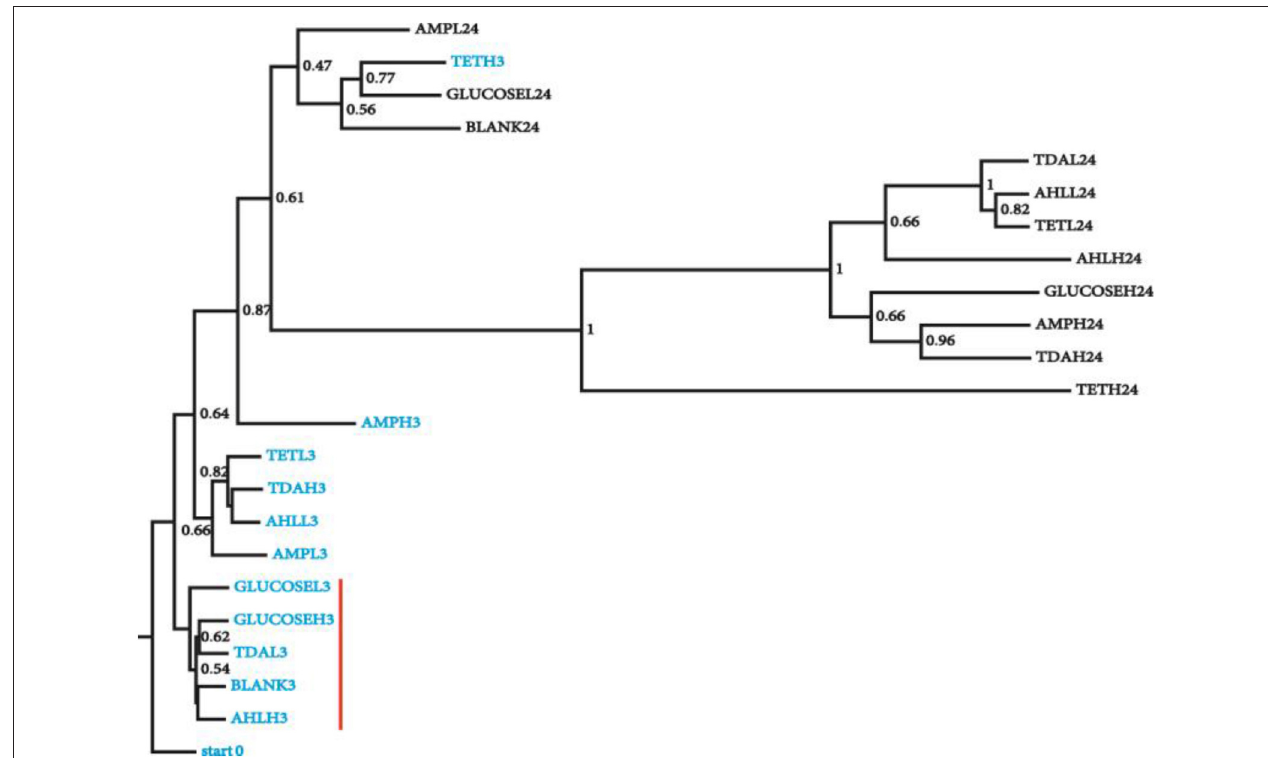
FIGURE 1 | Clustering of microbial diversity ( β -diversity) of the starting microbiota with the samples from different chemical treatments at 3 and 24h. Jackknifing of the UPGMA tree displays the robustness of clustering of the microbiota from the 3h from 24h samples. Bootstrap values are shown at the nodes of the tree, indicating percentage of jackknifed data supporting the node. Samples are named as following: chemical name (e.g., GLUCOSE), H/L (high/low concentration, e.g., L) and treatment time (e.g., 3), sample (GLUCOSEL3, treated with low amount of glucose for 3h). Samples from 3h (blue) treatment that were most similar to the starting microbiota are highlighted with a red vertical red